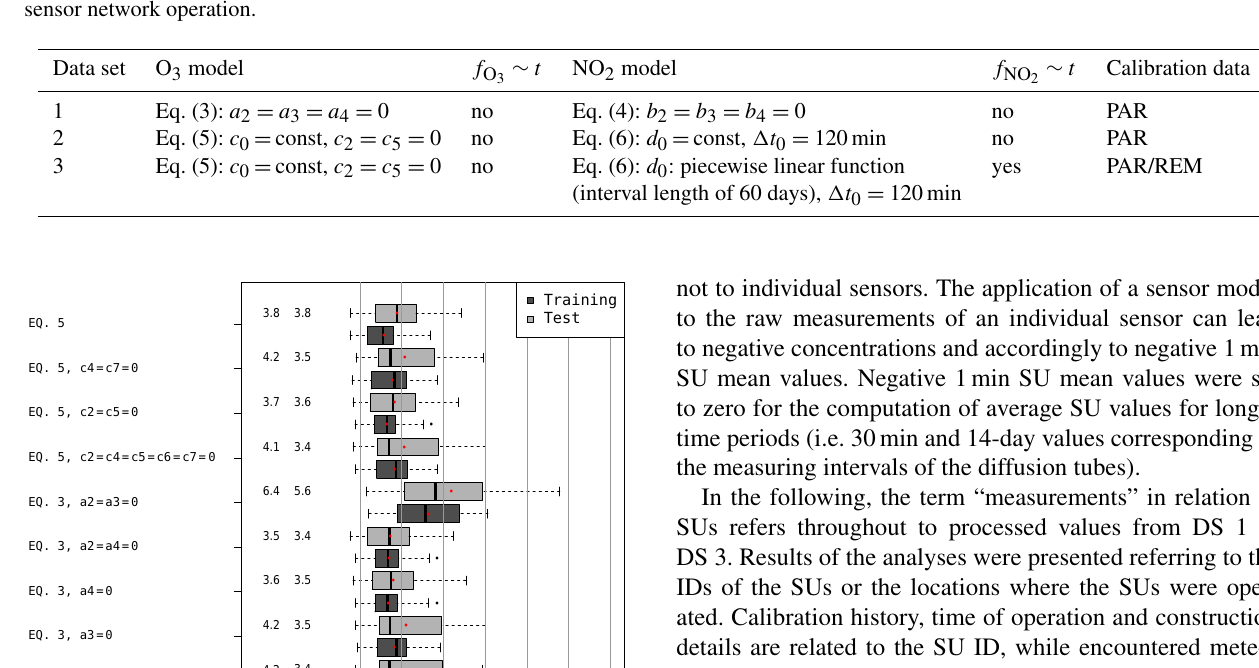
∼ t denote wether the model is time dependent. The descriptors PAR and ∼ t and f NO 2 3